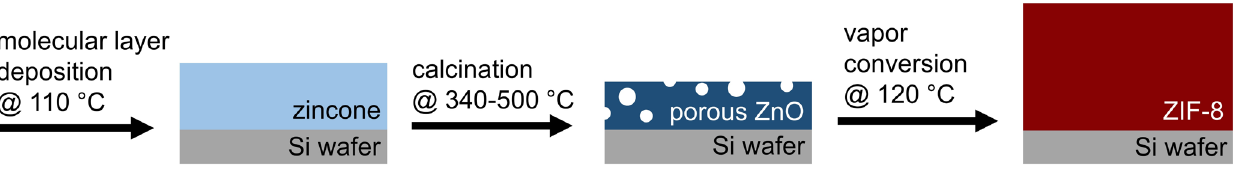
Figure 1. Schematic of the 3-step sample preparation process.